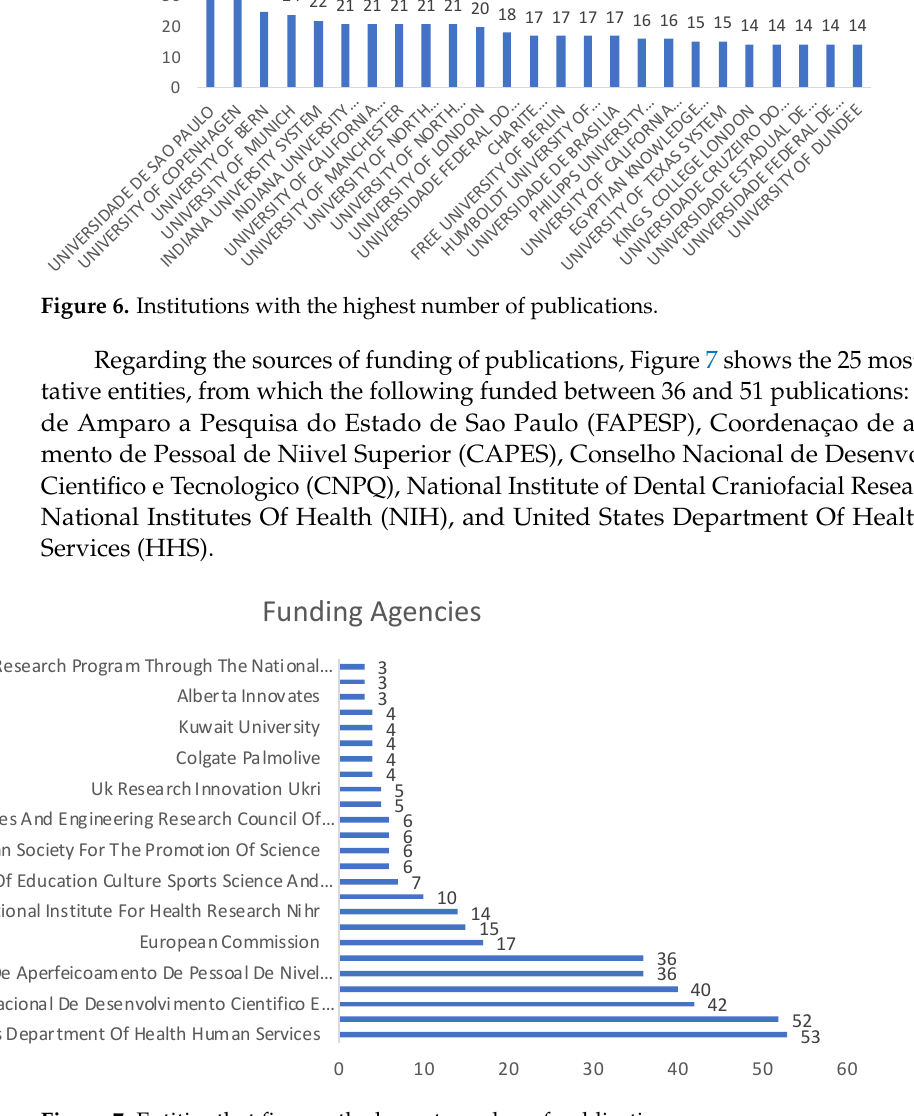
Figure 7. Entities that finance the largest number of publications.